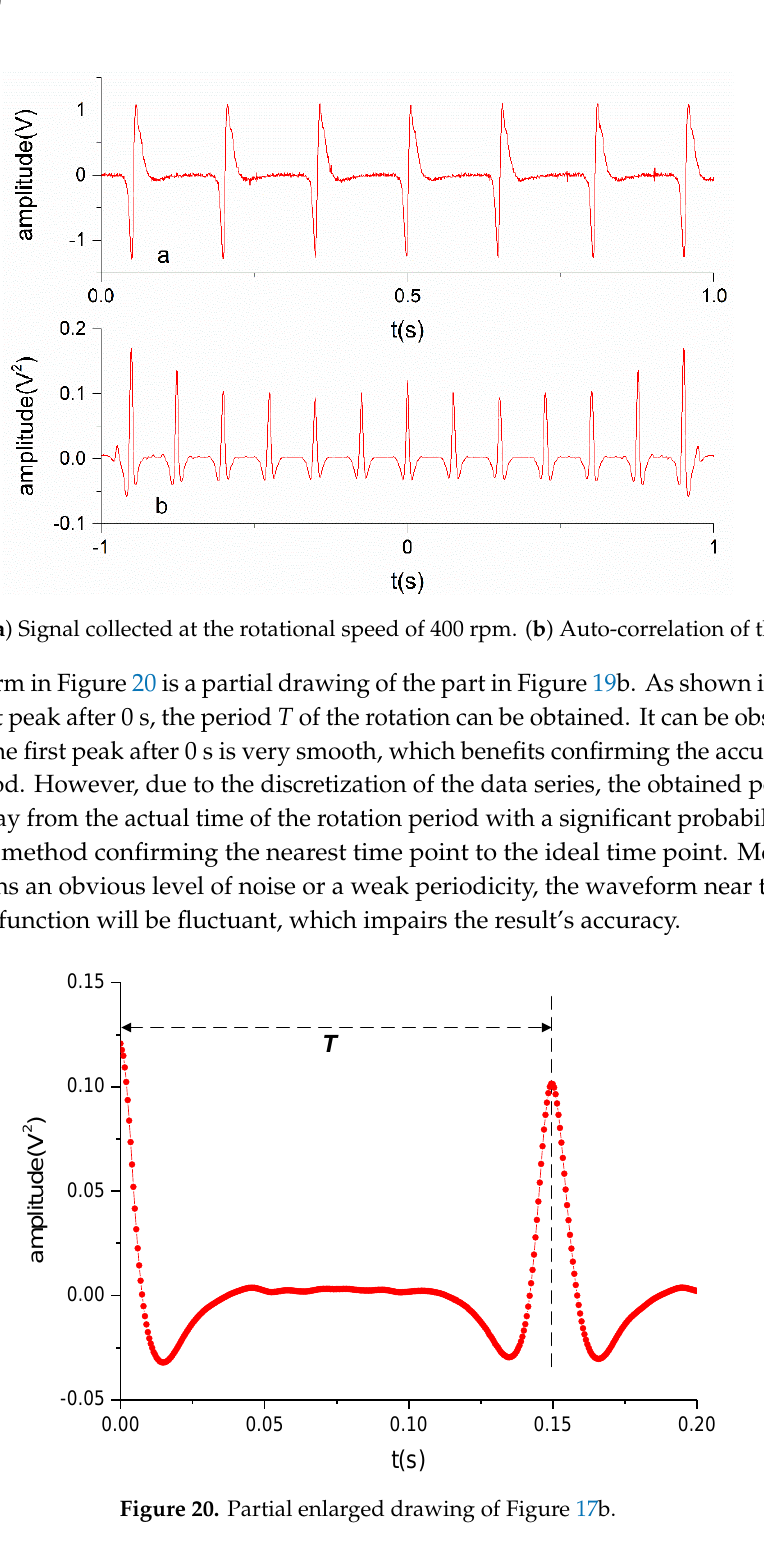
Figure 20. Partial enlarged drawing of Figure 17b.